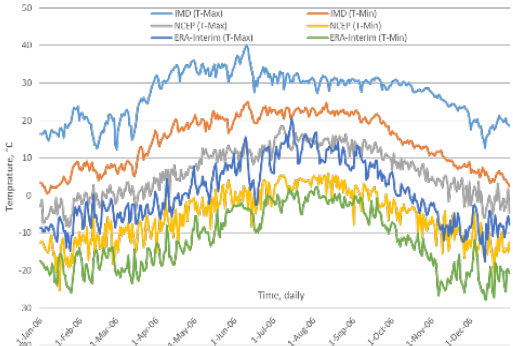
Figure 4.5. Comparison of temperature data sources for year 2006 (IMD, VIC-global & ERA-Interim) for entire Beas basin.